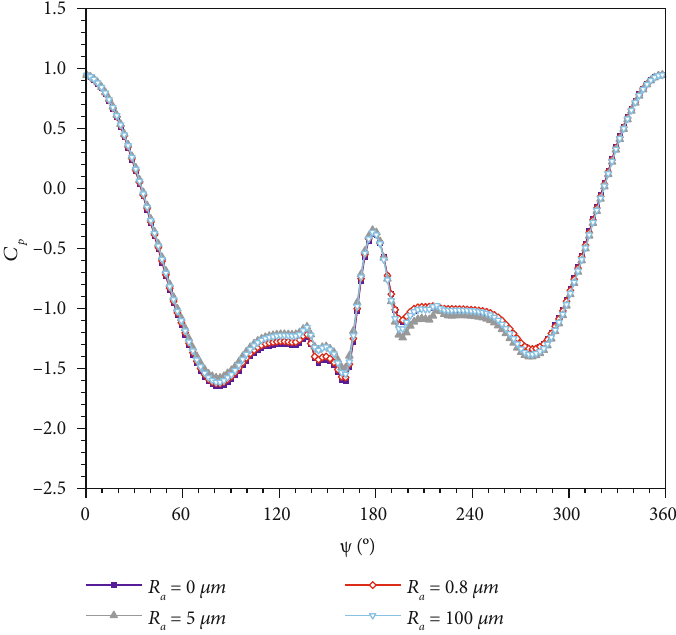
Figure 34: Pressure coe ffi cient distribution of di ff erent models at 1 D